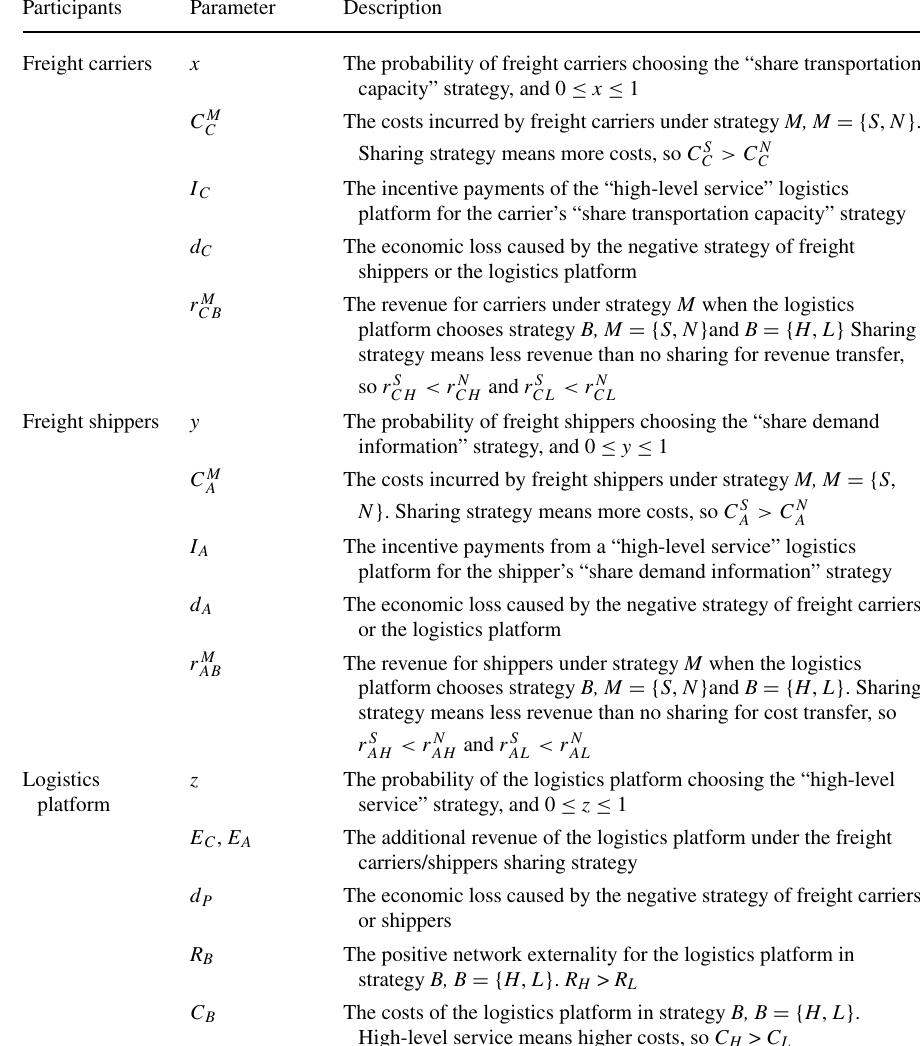
Table 1 Symbols and descriptions of the